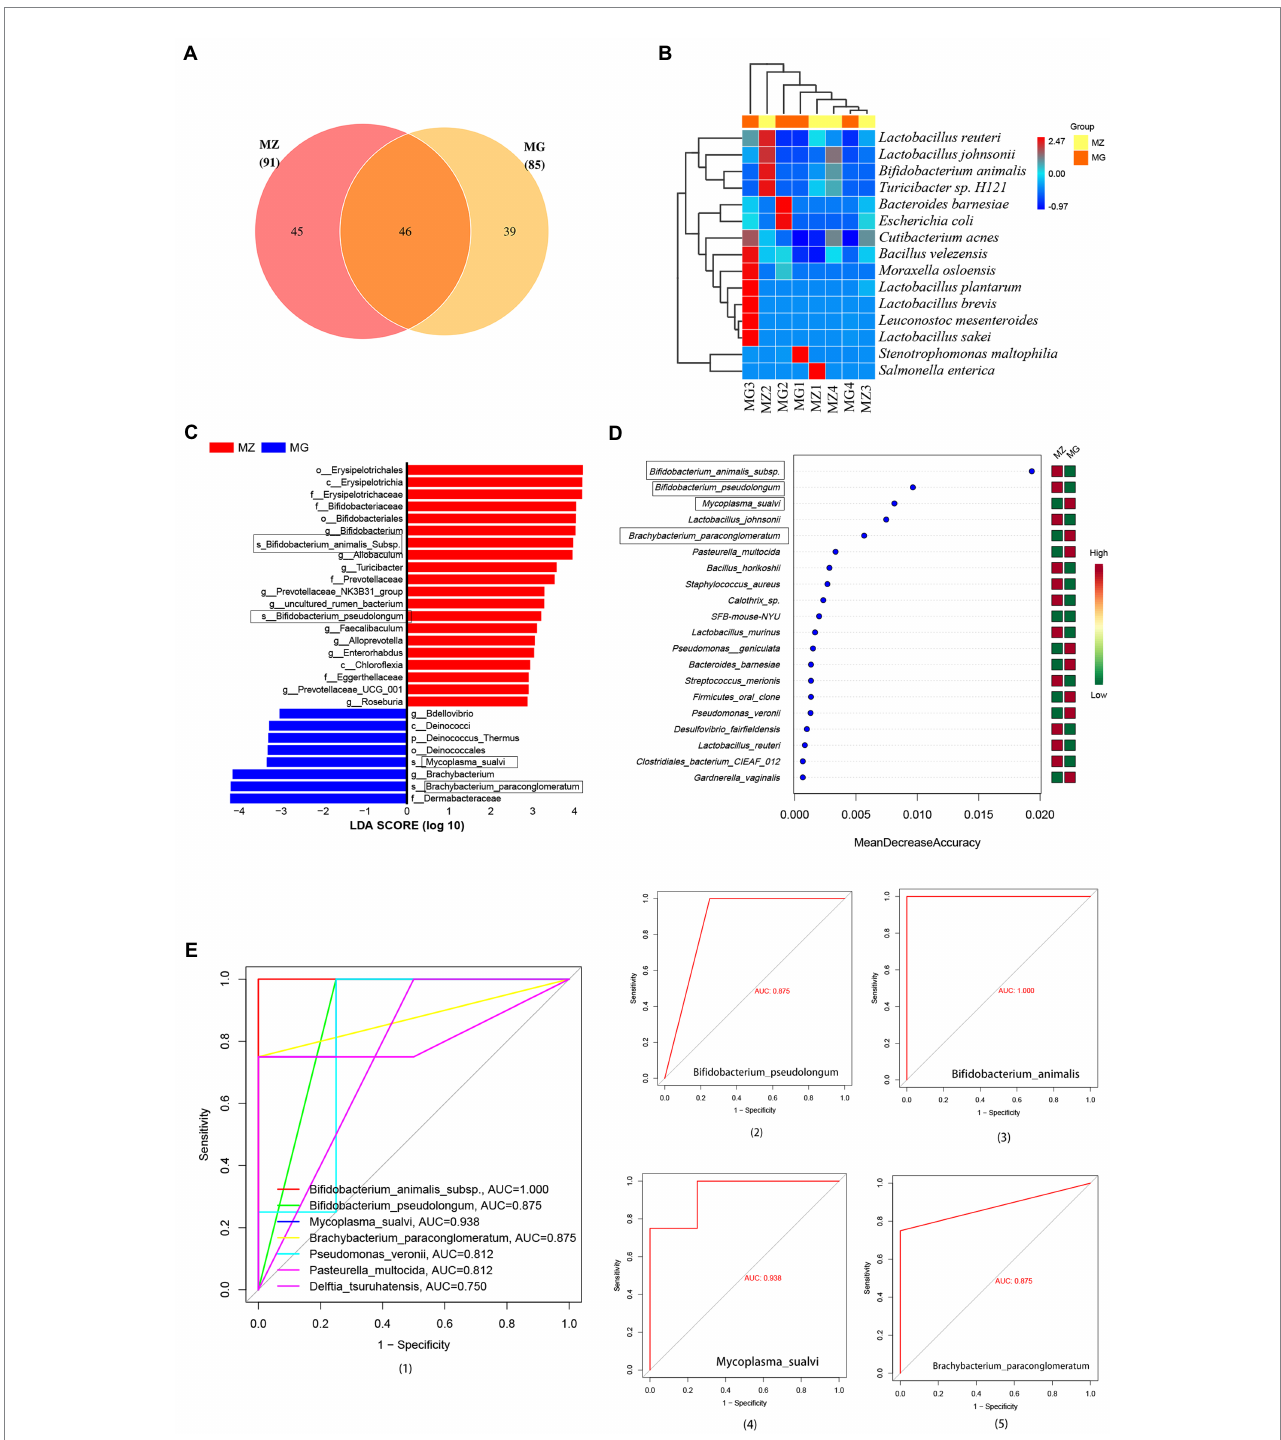
FIGURE 5 Intestinal mucosa microbiota biomarkers of hypertension induced by high salt diet. (A) OTU classification Venn diagram at species level. (B) Heatmap clustering of community species abundance at species level, and the closer the color is to red, the higher the abundance. (C) Cladogram generated from the LEfSe analysis indicating the phylogenetic distribution (LDA score ≥ 2, p < 0.05). (D) Random forest diagram of species level. (E) ROC curve of species level and ROC curve of intestinal mucosa microbiota biomarkers. MZ, normal group, MG, hypertensive